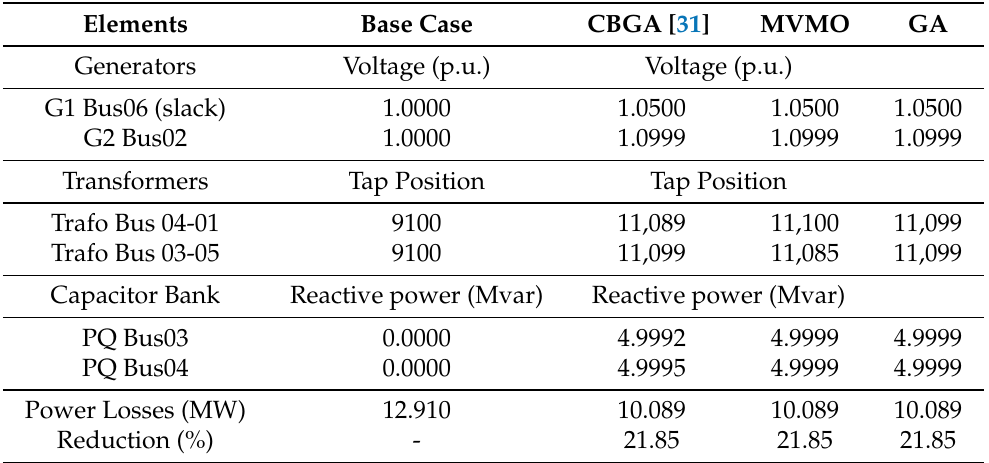
Table 8. Results for the IEEE 6-bus test